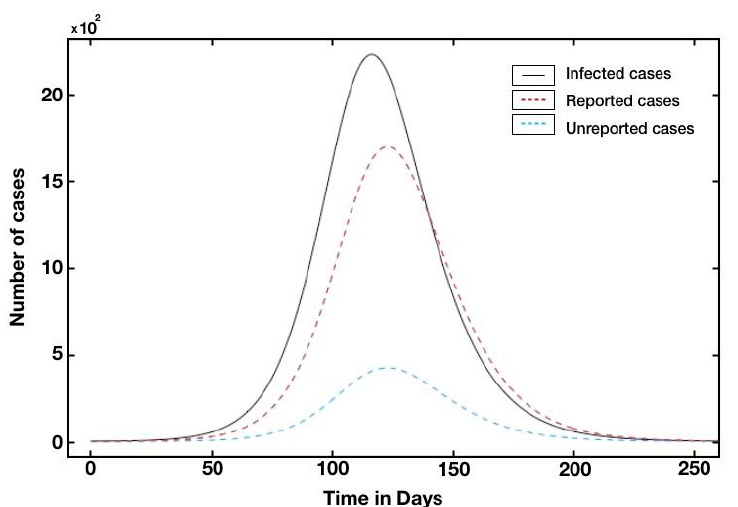
Figure 4. Simulated epidemiological curve without intervention. In this figure, we use f = 0.8, ν = 1/7, η = 1/7, and S 0 = 2.881 × 10 6 . The number of confirmed cumulative cases t → C ( t ) (black solid line) and t → U ( t ) is the unreported cases (blue dashed) and (red dashed) of the reported cases in Qatar. We use χ 1 = 215.08, χ 2 = 0.08, χ 3 = 145.48, t 0 = − 4.88 and S 0 = 2.881 × 10 6 , which give τ = 7.1 × 10 − 8 , I 0 = 10.1, U 0 = 1.3 and R 0 = 2.42.